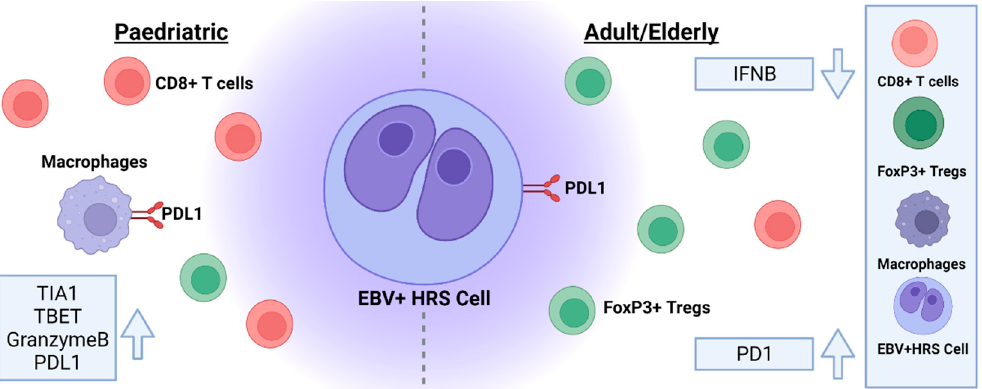
Figure 3. Schematic representation of differences in the cHL TME in different age groups. EBV- positive paediatric cHL has a more cytotoxic TME with predominant Th1 polarisation, overexpression of CD8, TIA1, TBET, and granzyme B, and fewer FoxP3+ regulatory T cells (Tregs) compared with EBV-negative disease. Fewer granzyme B-positive T cells, increased Tregs, and limited interferon beta production in older adult/elderly EBV-positive cHL indicate a more immunosuppressive